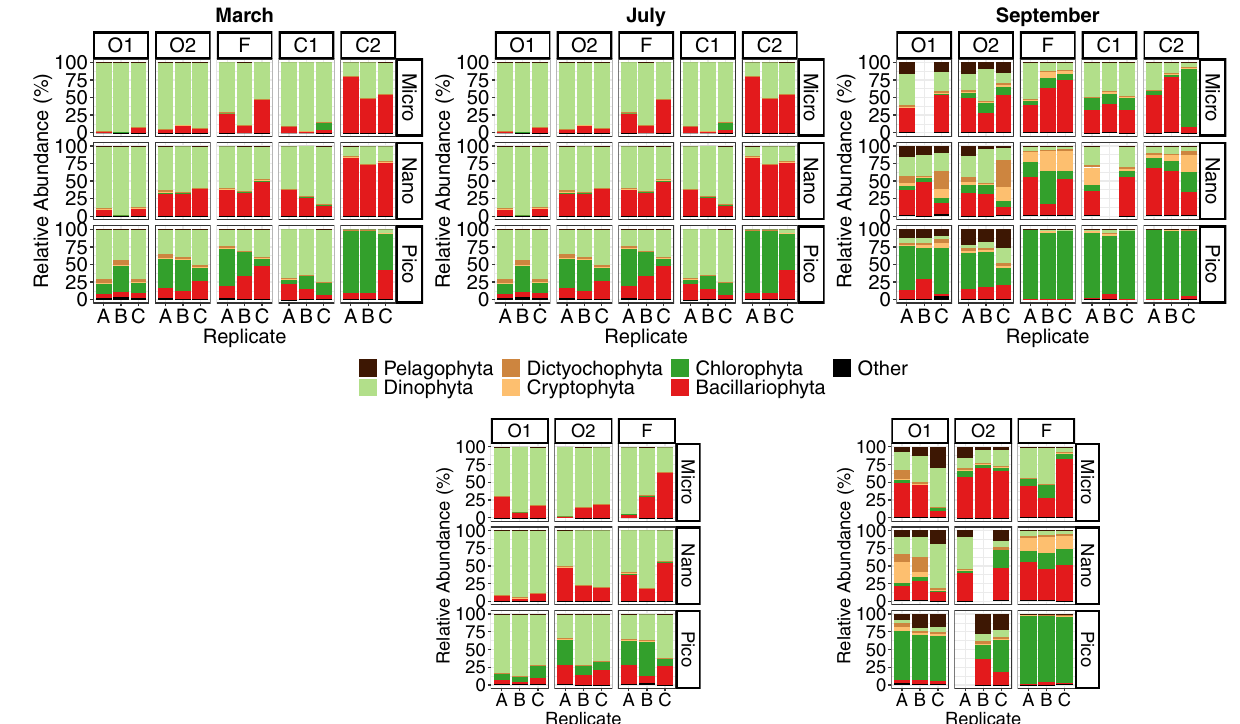
Figure 2. Proportions of eukaryotic phytoplankton taxa estimated by DNA-barcoding in the Iroise Sea in March, July and September 2015. Samples are organized by replicates, size-fractions, sampling stations, depths (surface and Deep Chlorophyll Maxima, DCM) and seasons. The relative abundance was calculated based on the number of reads of the OTUs corresponding to the shown phytoplankton taxa, ‘Other’ represents the proportion of taxa with a relative abundance < 10% over the